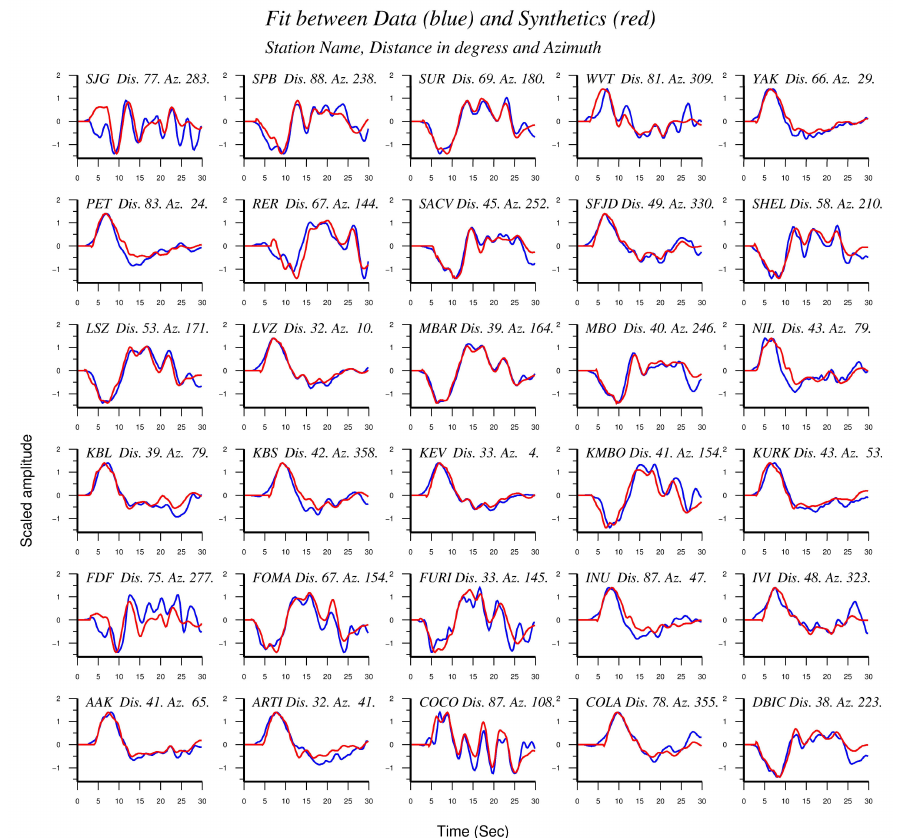
Figure 6. Fit between real P-waveforms and synthetics for the 30 stations illustrated in Figure